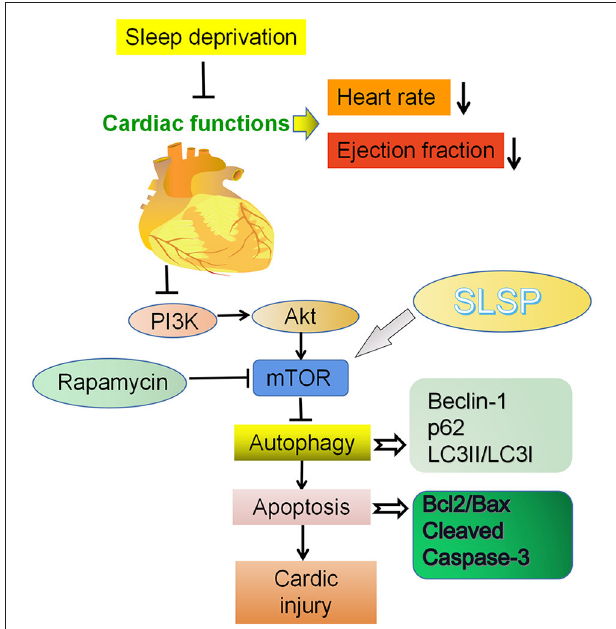
FIGURE 8 | Cardioprotective effect of SLSP on a sleep deprived mice by inhibiting abnormal autophagy through PI3K/Akt/mTOR